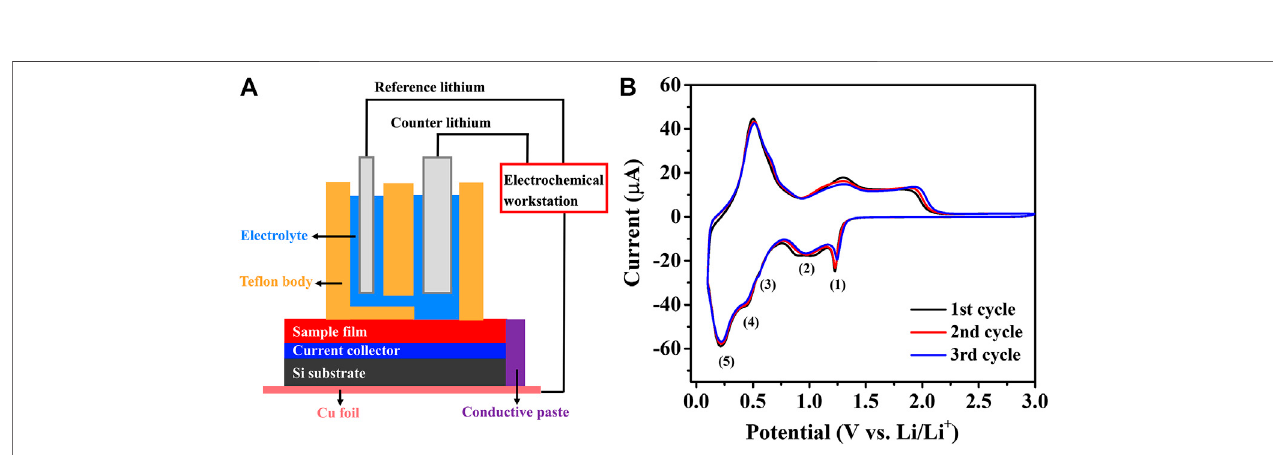
FIGURE 2 | (A) XRD patterns of SnO 2 – MO x composite and MO x reference. XPS spectra of SnO 2 – MO x : (B) survey scans, (C) atomic concentration (at%) depth pro fi les and high-resolution scan of (D) Ti 2p in SnO 2 – TiO 2 , (E) Fe 2p in SnO 2 – Fe 2 O 3 and (F) Zn 2p in SnO 2 –